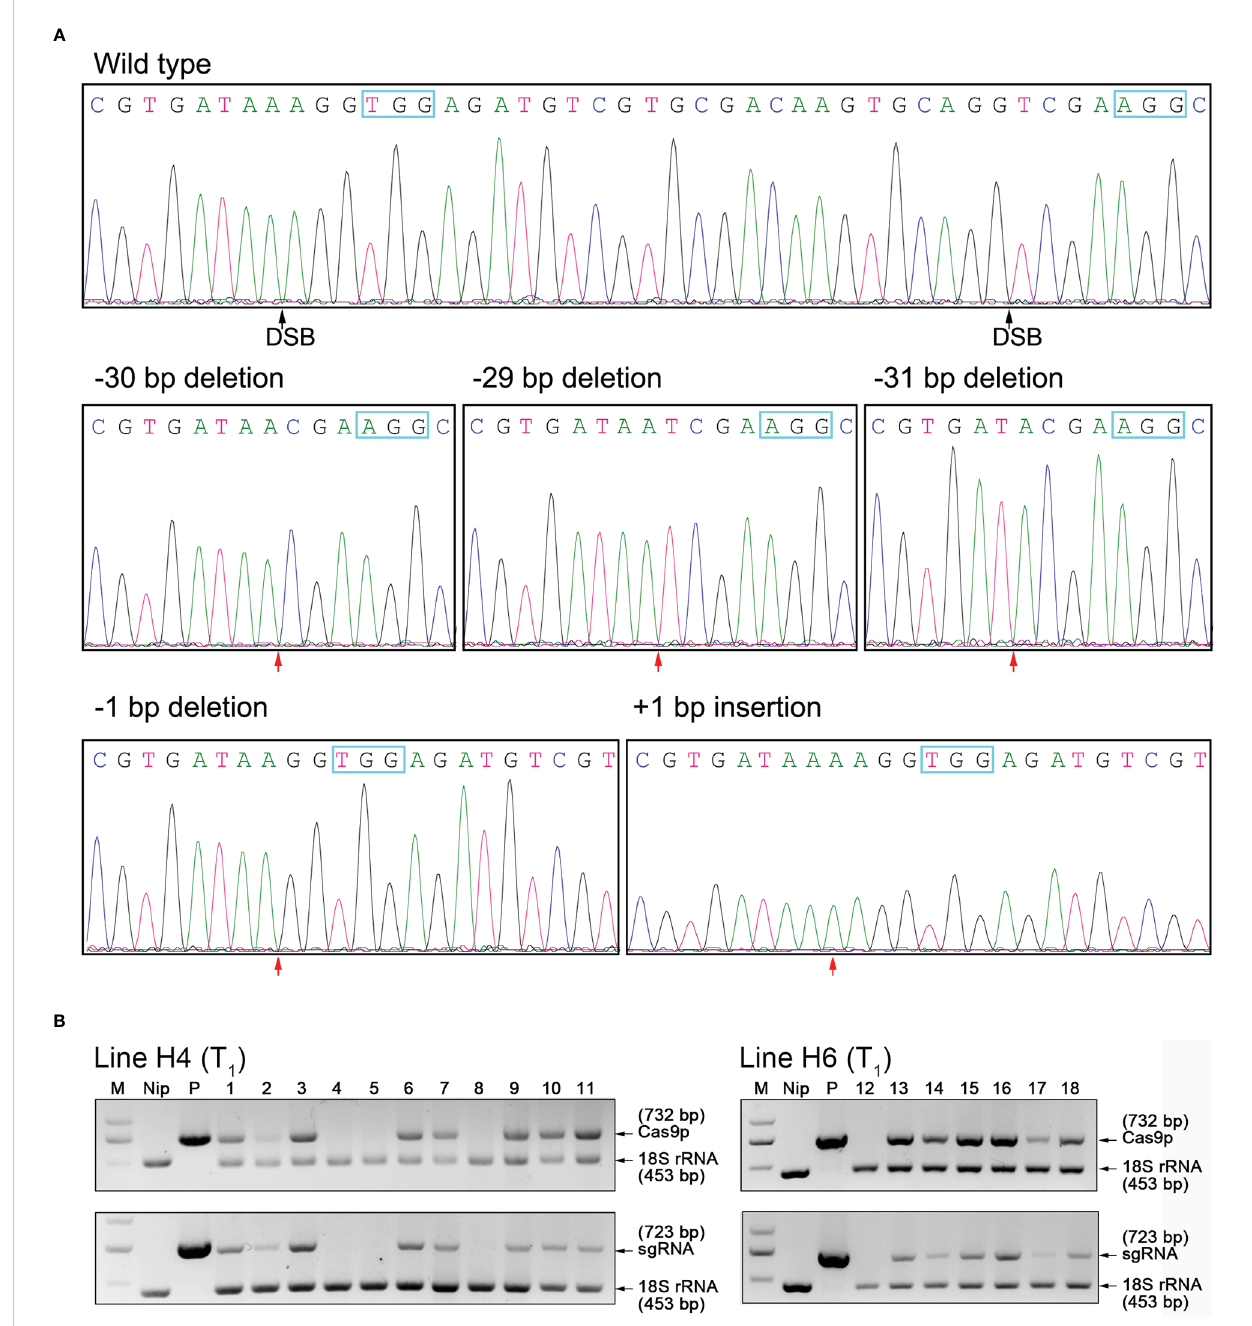
FIGURE 2 Detection of Homozygous OsHPP04 mutants of rice. (A) Sanger sequencing results for OsHPP04 mutants in T 1 generation. The protospacer adjacent motif (PAM) sequences are shown in blue box. DSB indicate double-strand breaks. The red arrowheads indicate the location of mutations. (B) PCR-based test for identifying ‘ transgene-free ’ OsHPP04 mutants of rice. Cas9p (732 bp), part of the Cas9 coding sequence. sgRNA (723 bp), region ranging from the OsU6a promoter to the downstream of gRNA2. 18S rRNA (453 bp), part of the 18s rRNA sequence as a normalization control. M, DL2000 DNA marker. Nip, wild-type rice DNA. P, plant pYLCRISPR/Cas9-Pubi-H- OsHPP04 -KO binary vector. Lanes 1-11 and 12-18, individual offspring of Line H4 and